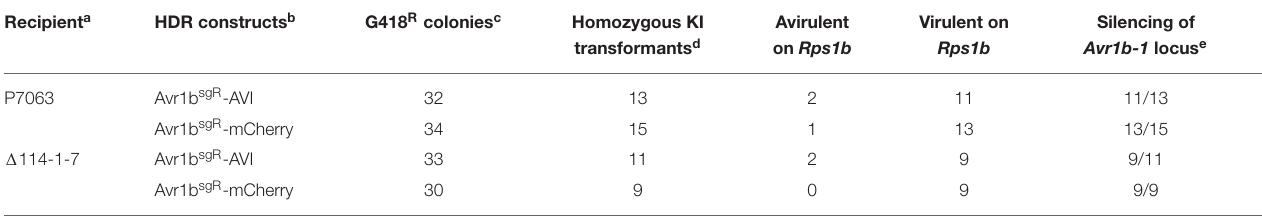
FIGURE 7 | Characterization of Avr1b-1 knock-in transformants derived from Avr1b-1 sgR fusion genes. (A) Lesions produced by transformants and control strains. Transformants were Avr1b sgR -AVI KI strains C4W3, C4W6, and C4W7, and Avr1b sgR -mCherry KI strains C8W1, C8W2, and C8W15. Control strains were wild-type P7063, Avr1b-1 deletion transformant (cid:49) 114-1-7, Avr1b sgR -AVI failed KI strain C4W4f, and Avr1b sgR -mCherry failed KI strain C8W3f. Zoospores from each strain were inoculated onto unifoliate leaves of soybean cultivar Williams ( rps1b ) or L77-1863 ( Rps1b ). Pictures were taken 3 days after zoospore inoculation. (B) Average lesion sizes on unifoliate soybean leaves inoculated with wild-type or transgenic P. sojae , measured from eight leaves in each of three independent experiments. Pictures were taken 3 days after inoculation, then relative lesion sizes were measured with ImageJ software. Error bars represent the mean ± standard deviation. P -values were calculated with the Wilcoxon rank sum test, *** P < 0.001. n.s. P > 0.1. (C) Avirulence phenotypes of Avr1b-1 knock-in transformants measured by real-time PCR-based quantification of P. sojae genomic DNA in infected tissue. Proliferation of P. sojae is plotted as the ratio between the relative abundance of PsActin DNA to GmActin DNA in infected L77-1863 leaves compared with Williams leaves at 72 hpi. This experiment was replicated three times. Error bars represent the mean ± standard deviation. P -values were determined with the Wilcoxon rank sum test. *** P < 0.001, n.s. P > 0.1. (D) Transcript levels produced by genes resident at the Avr1b-1 locus in wild-type and transgenic lines during soybean infection at 36 hpi. Levels were assayed by qRT-PCR using Avr1b-1 primers except for (cid:49) 114-1-7, for which mCherry primers were used ( Supplementary Table S3 ). Transcript levels were normalized against P. sojae Actin . Error bars represent the mean ± standard deviation. P -values were calculated with the Wilcoxon rank sum test, *** P < 0.001, n.s. P > 0.1. RNA samples from the Avr1b-silenced isolate P6497 and in vitro -grown P7063 (P7063-My) were analyzed as controls. (E) Avr1b-mCherry fusion proteins preferentially accumulate in haustoria. Haustorial accumulation of Avr1b-mCherry during infection of etiolated hypocotyls by C8W1 (right panel) compared with uniform cytoplasmic distribution of mCherry in (cid:49) 114-1-7 (left panel). Images were obtained by confocal microscopy at 36 hpi. Scale bars = 20 µ m.